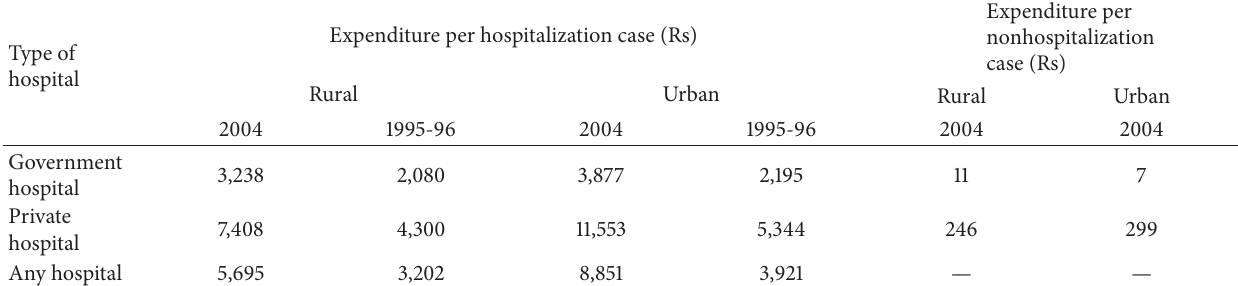
Table 9: Average medical expenditure (Rs) per hospitalization and nonhospitalization case.